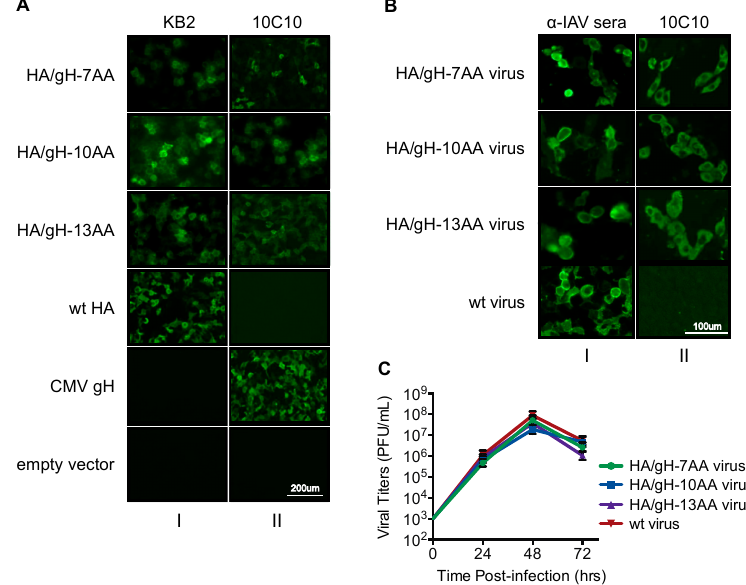
Figure 2. The gH peptide within the HA / gH chimeric viruses is conformationally similar to the native CMV gH protein. ( A ) Immunofluorescence staining of HEK293T cells transfected with plasmids encoding the HA / gH chimeras (HA / gH-7AA, HA / gH-10AA, and HA / gH-13AA), wild-type (wt) HA, and the full CMV gH protein were probed using anti-influenza A monoclonal antibody (KB2) and anti-CMV gH monoclonal antibody (10C10). Empty vector was utilized as a negative control. ( B ) MDCK cells infected with the chimeric HA / gH and wt-influenza viruses (MOI 0.25) were probed at 48 hpi with 10C10 and anti-influenza A polyclonal mouse serum ( α -IAV sera). ( C ) Growth curves in MDCK cells of the chimera HA / gH viruses (HA / gH-7AA, HA / gH-10AA and HA / gH13AA) and of the wt-influenza virus (wt